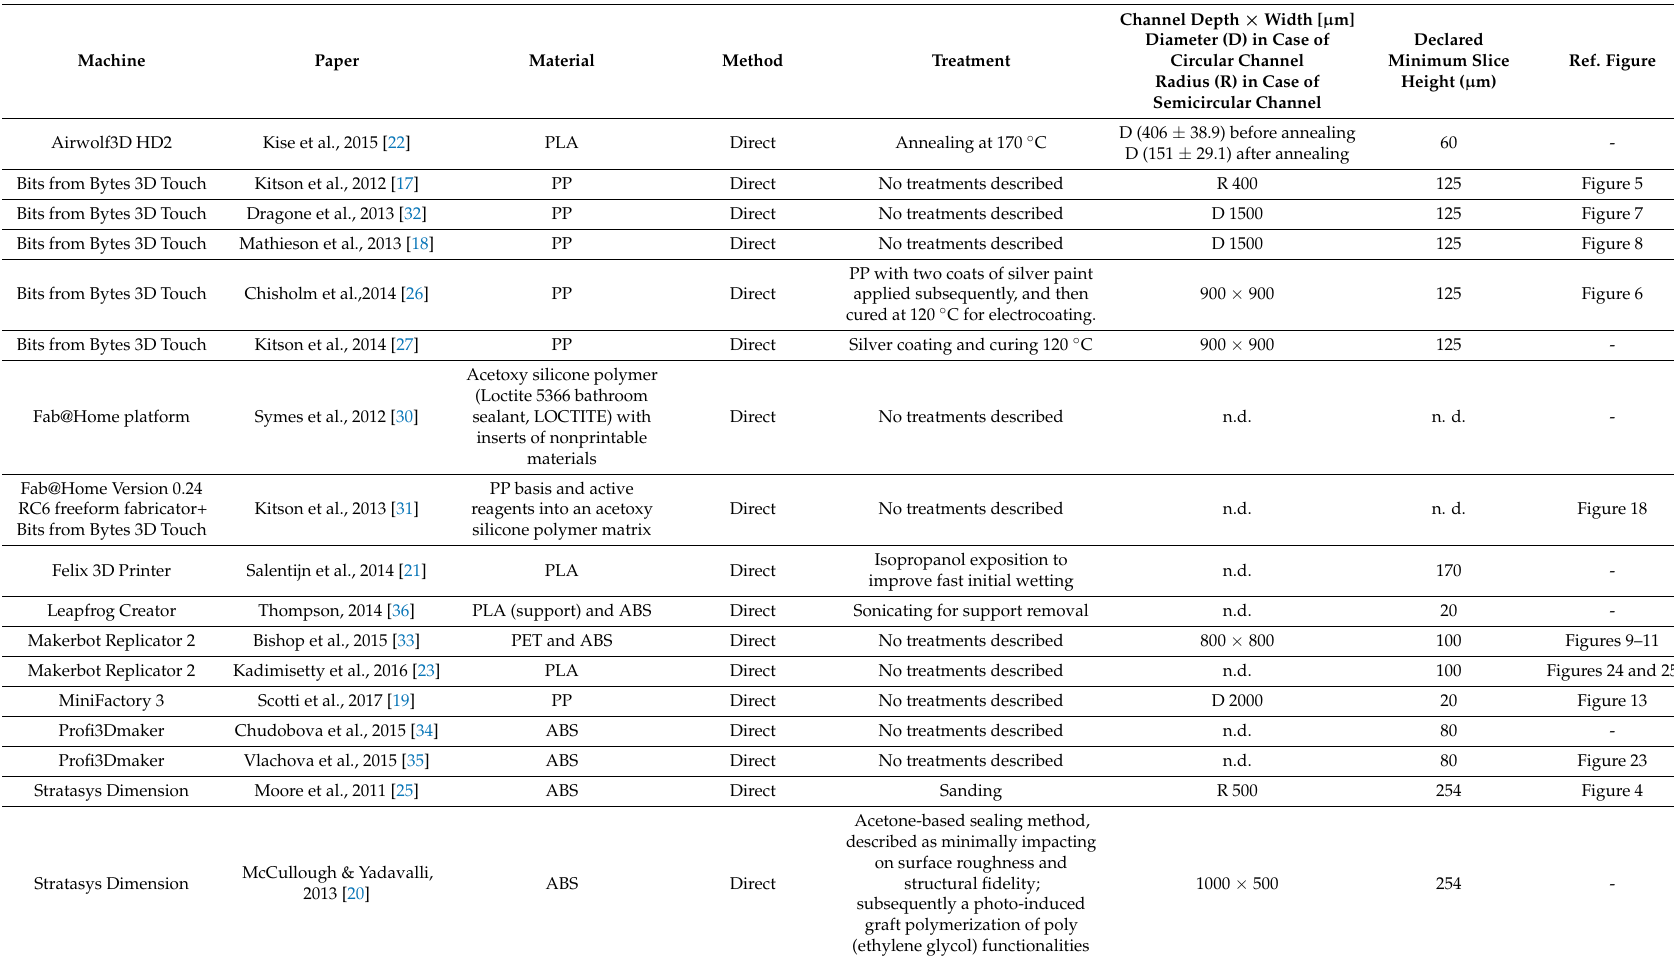
Table 1. Summary of the microfluidic applications of FFF related to machine